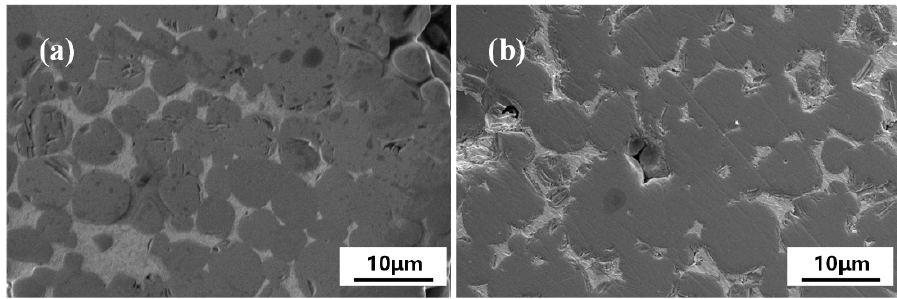
Figure 7. SEM micrographs of the sintered green bodies in a vacuum induction melting furnace. ( a ) No soaking and ( b ) soaking at 1200 °C for 15 min.